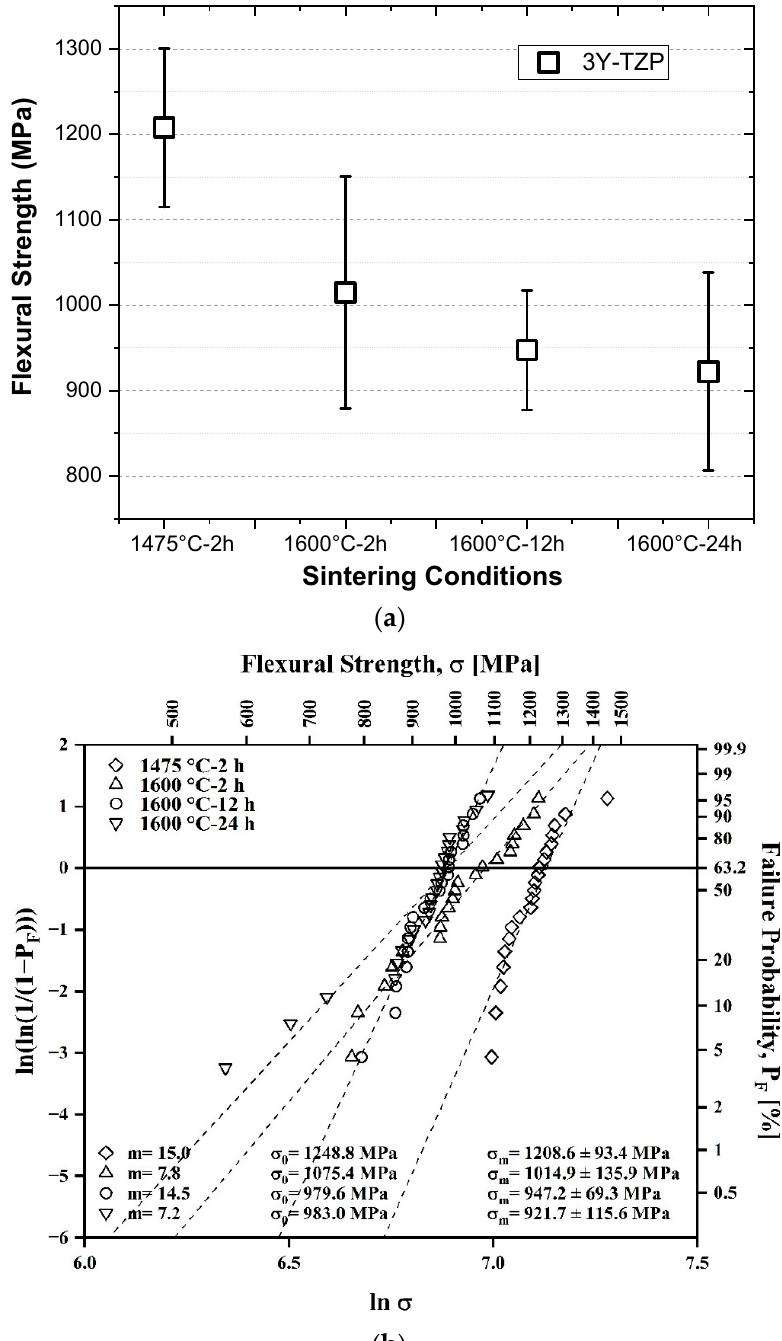
Figure 7. ( a ) Biaxial flexural strength results for Y-TZP ceramics after sintering. ( b ) Weibull distributions for groups of Y-TZP ceramics sintered under different conditions. Table 3. Comparative statistical analysis (Tukey test/ANOVA) of flexural strength of Y-TZP ceramics.